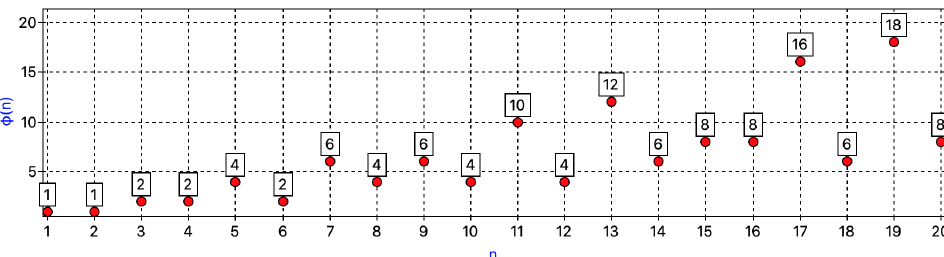
Figure 6. The simulation for ϕ ( n ) with 1 ≤ n ≤